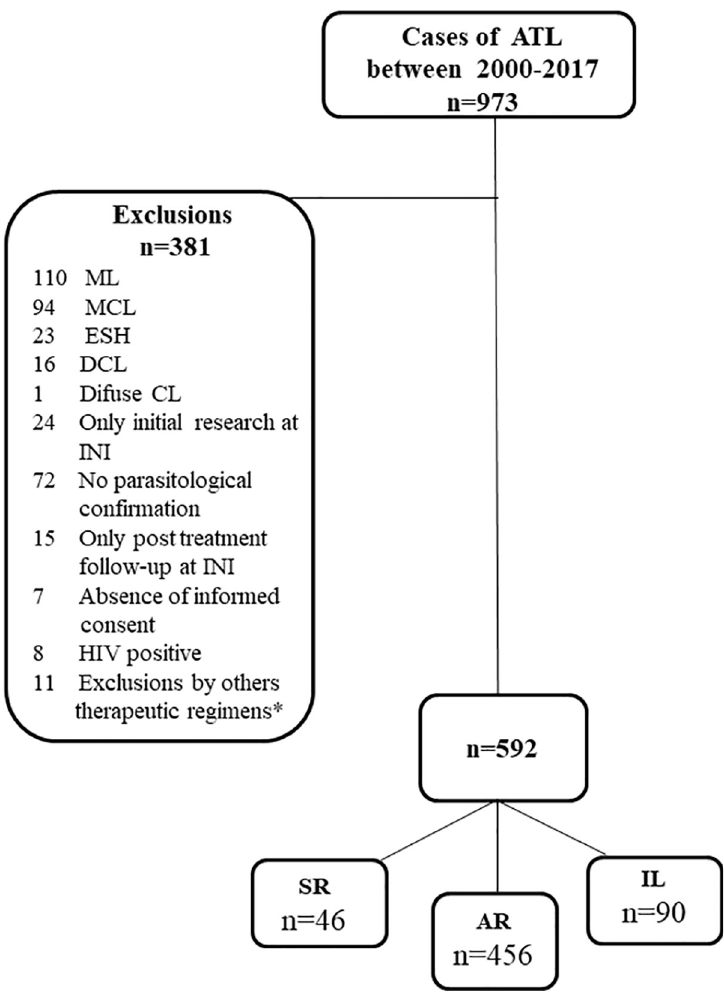
Fig 1. Flowchart of inclusion and exclusion of the studied patients, for the population of patients with American tegumentary leishmaniasis treated at INI, 2000–2017. MA- meglumine antimoniate; INI- Evandro Chagas National Institute of Infectious Diseases; Fiocruz- Oswaldo Cruz Foundation; ML- mucosal leishmaniasis; MCL- mucocutaneous leishmaniasis; ESH- early spontaneous resolution without treatment; DCL- disseminated cutaneous leishmaniasis; CL- cutaneous leishmaniasis; HIV- human immunodeficiency virus; LCL- localized cutaneous leishmaniasis; SR- standard regimen with MA 10 to 20 mg/kg/day; AR- alternative regimen with MA 5 mg/kg/day; IL- intralesional MA. � MA used as first therapeutic